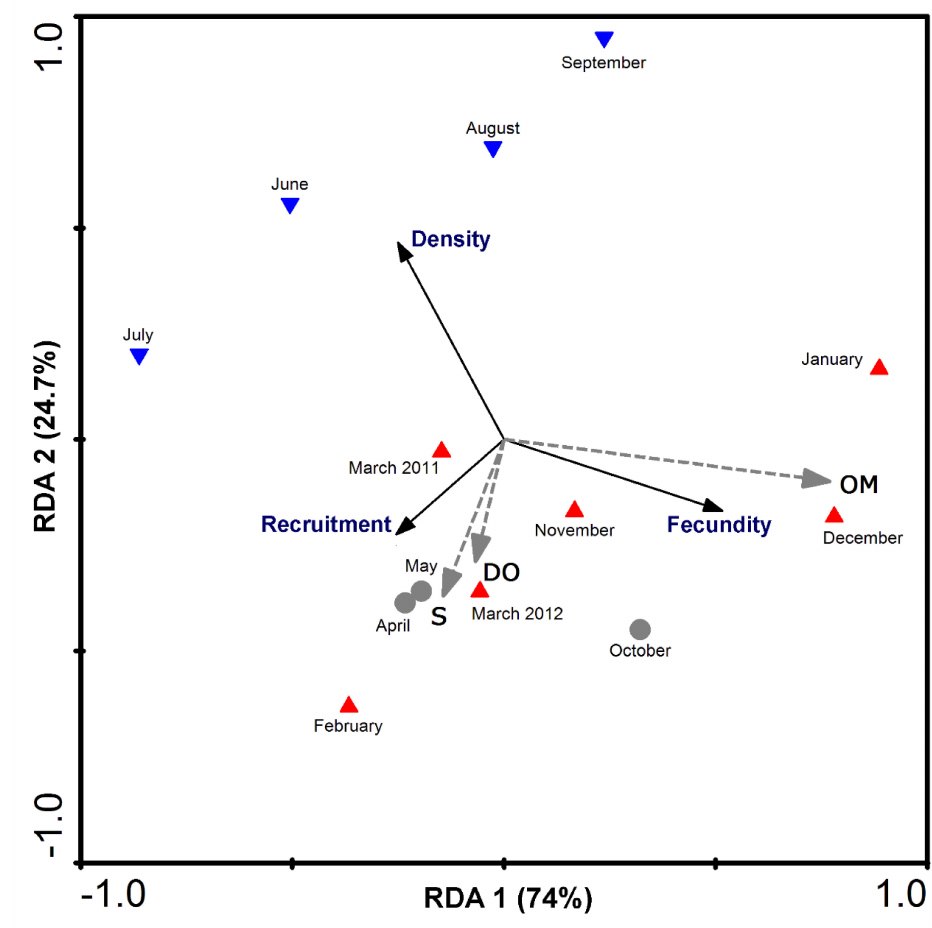
Figure 3. Biplot diagram of constrained RDA with data of usual population attributes (full black arrow) and environmental variables (dotted gray arrow). Biological variables (total density, recruit- ment, and fecundity) were previously selected to control for autocorrelation. A stepwise forward selection criterion has included only three environmental variables in the RDA that contributed significantly to the model explanation: salinity (S), dissolved oxygen (DO) in the bottom water, and organic matter in the sediment (OM). Distinct symbols and colors indicate that samples were collected in the warm-rainy ( (cid:78) ), intermediate ( • ), and cold-dry seasons ( (cid:72) ). A second constrained RDA was applied to detect the relationship of stress-related vari- ables (i.e., response variables) to environmental data (i.e., explanatory variables), following a stepwise forward selection model of environmental variables. RDA axes 1 and 2 showed species-environment correlations of 0.946 and 0.878, respectively, accounting for a percent- age variance of species-environment relation of 99.5% (Eigenvalue RDA 1 = 0.890) and 0.4% (Eigenvalue RDA 2 = 0.003) (Figure 4). All the canonical axes of RDA showed statistical significance (Monte Carlo permutation, F-ratio = 6.060; p = 0.048). A PERMANOVA was applied to test for differences in stress-related population attributes among seasonal groups. Overall, a significant influence of seasonal periods on the explicability of stress-related attributes was only detected between warm-rainy and cold-dry seasons (PERMANOVA, F = 1.349; p =